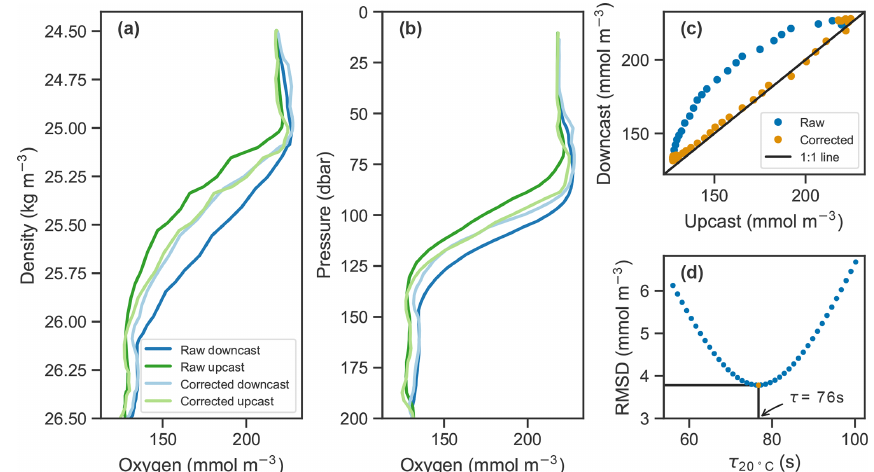
Figure 2. Example of raw oxygen measurements from a downcast and an upcast (darker blue and green lines, respectively) and corrected profiles (lighter lines) in (a) density and (b) pressure coordinates. (c) Upcast and downcast (top 150m) plotted against each other with raw data in blue and corrected data in orange. (d) The root-mean-square difference (RMSD) between the upcast and downcast after correcting casts for a range of time constants, τ , showing the optimal τ value at 20 ◦ C in this case of 76s in orange.